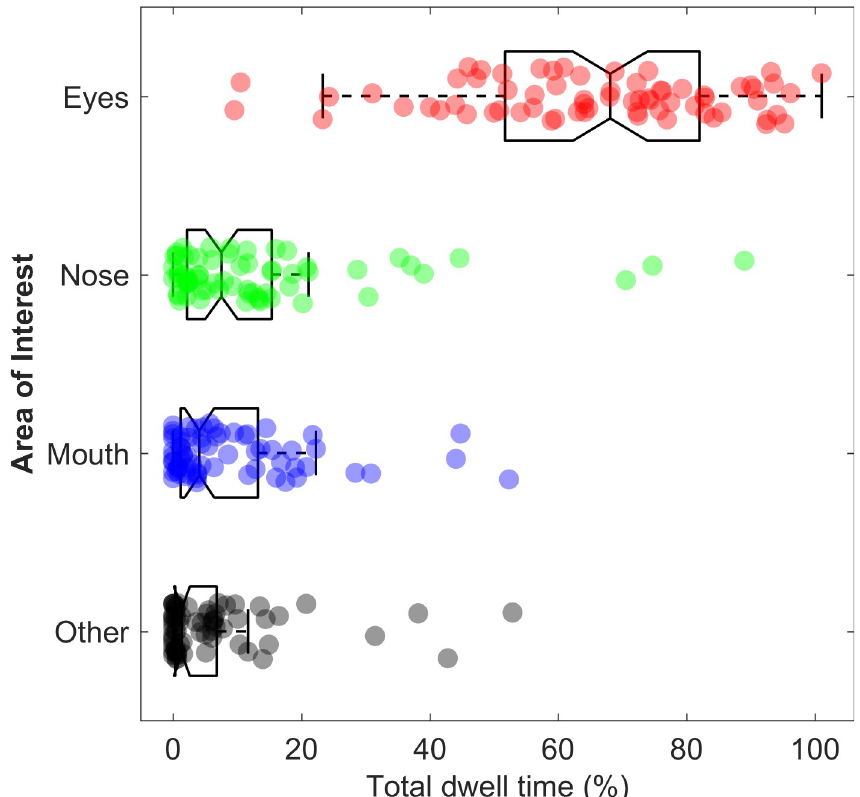
Fig 5. Box and whisker plots for relative total dwell time (%) per area of interest. Boxplots are overlaid with individual data points which are jittered in the vertical direction to avoid overlap. Each dot represents data from one of 68 participants. Boxes cover the 25 th to 75 th percentile (inter-quartile range; IQR). The middle of the box represents the median. Whiskers extend from the 25 th percentile and 75 th percentile to cover all data points lying within 1.5 times the IQR from the 25 th and 75 th percentile respectively. Notice that the relative total dwell times (%) on the nose, mouth, and ‘other-AOI are not normally distributed. Many participants gazed at these AOIs only for a relatively small amount of the video clip duration ( � 30 seconds), or did not look at these AOIs at all, hence the bounded and skewed distributions and the large clusters of datapoints at or near